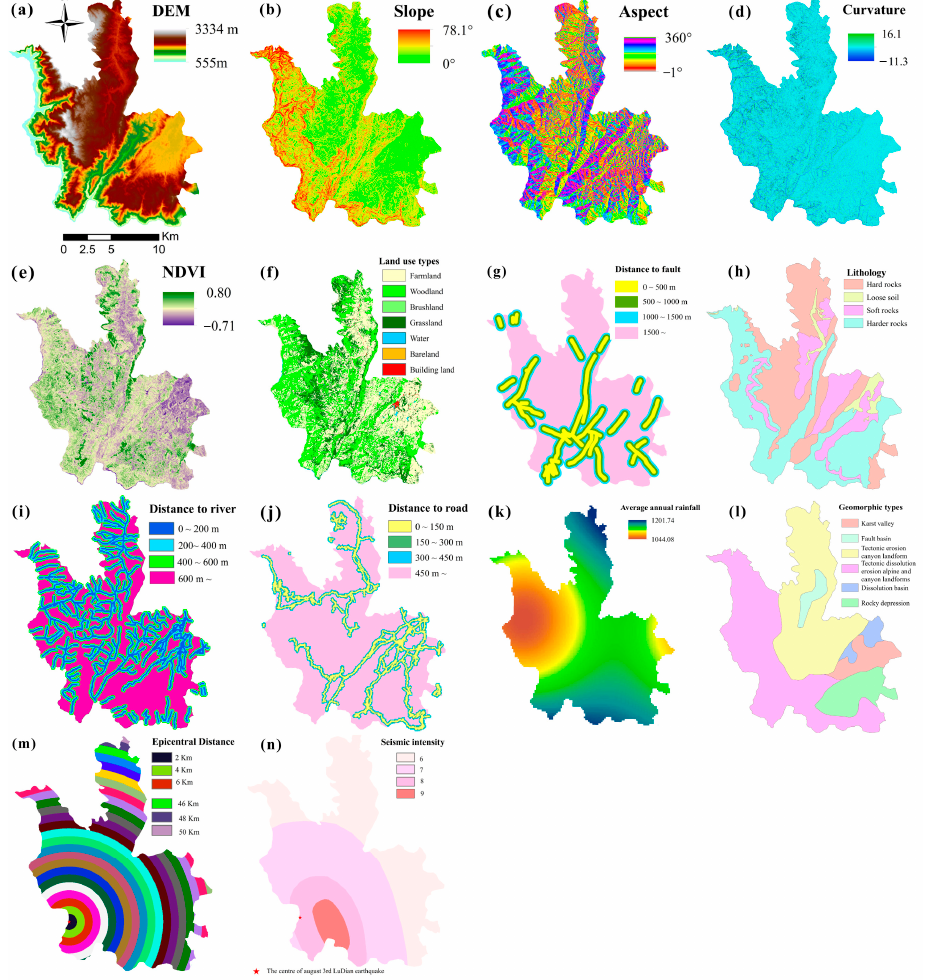
Figure 2. Landslide susceptibility assessment factors. ( a ) DEM. The DEM is the data source for elevation and other topographic factors. ( b ) Slope. Slope describes the degree of slope inclination and influences the landslide stability. ( c ) Aspect. Aspect represents the orientation of the slope and affects the soil moisture and weathering of landslide. ( d ) Curvature. Curvature expresses the rate of change of aspect along a contour. ( e ) NDVI. NDVI is an index that indicates on the growth status and quantity distribution of plants. ( f ) Land use. The Land use affects the soil mechanical properties and hydrological environment. ( g ) Distance to fault. Faults affects the stability of slopes by cutting rocks and soils. ( h ) Lithology. The lithology type affects the landslide development by affecting the shear strength of the slope. ( i ) Distance to river. Rivers affect landslide development because the strength of the rocks and soils are eroded by the rivers. ( j ) Distance to road. The distance to roads is related to human engineering activities. The activities contribute to a change in topography and generally accelerate slope instability. ( k ) Average annual rainfall. Rainfall induces the occurrence of landslide. ( l ) Geomorphic types. The geomorphic types areimportant factors in determining the stability of landslides. ( m ) Epicentral Distance. The epicentral distance map was drawn with the center of the earthquake in Ludian County on 3 August 2014 as the center of the circle and every 2 km as the radius to reflect the relationship between earthquake and landslide in the study area. ( n ) Seismic Intensity. The seismic intensity map indicates the possibility of landslides induced by different earthquake intensities in the study